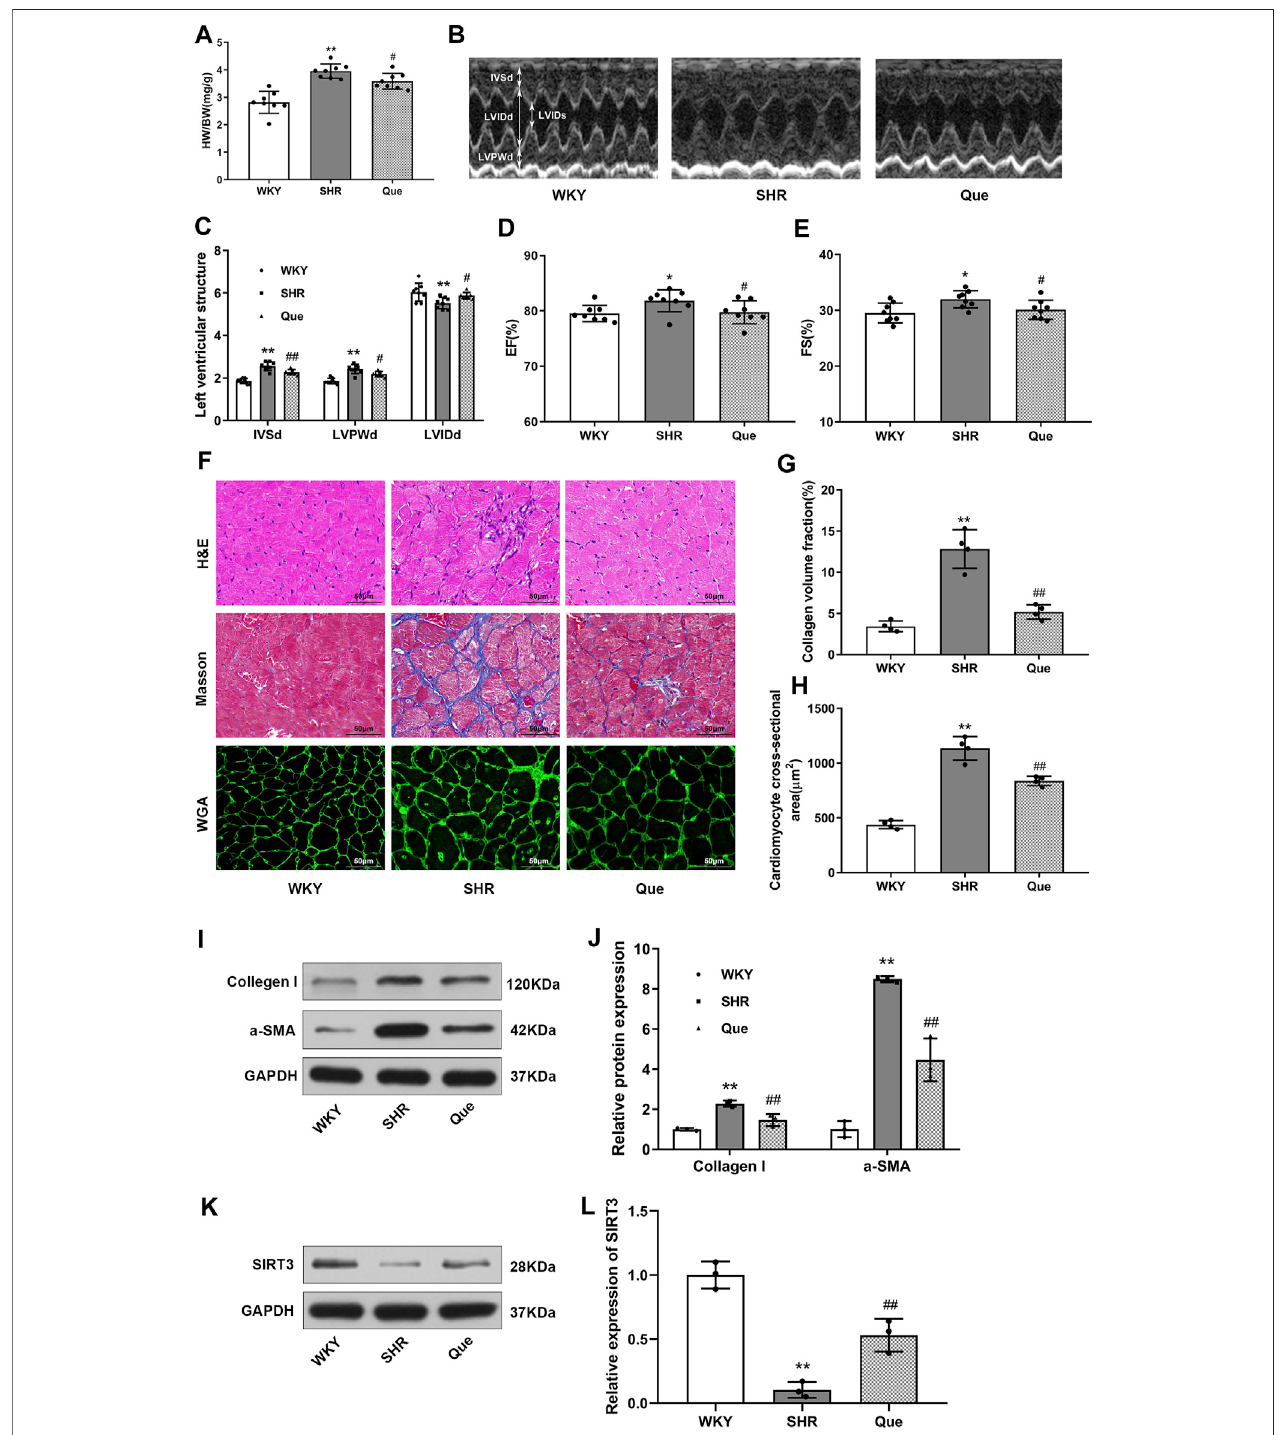
FIGURE 2 | Quercetin attenuates cardiac hypertrophy in SHRs. (A) Heart weight to body weight ratios (HW/BW, n (cid:1) 8). (B) Representative M-mode echocardiograms in WKY rats and SHRs. (C – E) Quantitative analysis of end-diastolic interventricular septal thickness (IVSd), left ventricular end-diastolic posterior wall thickness(LVPWd),leftventricularend-diastolicinternaldiameter(LVIDd),leftventricularejectionfraction(LVEF)andleftventricularfractionalshortening(LVFS)(n (cid:1) 8). (F) Representative histological images of the myocardium. In detail, hematoxylin and eosin (H&E) staining, Masson ’ s trichrome staining, and wheat germ agglutinin (WGA) staining in hearts from WKY rats and SHRs. Scale bar (cid:1) 50 μ m. ( G) Quantitative analysis of collagen volume fraction (n (cid:1) 4). (H) Quantitative analysis of cardiomyocyte cross-sectional area (n (cid:1) 4). (I,J) Representative blots of collagen I and α -smooth muscle actin ( α -SMA), and densitometric quanti fi cation after normalization to GAPDH levels (n (cid:1) 3). Data are mean ± SD. * p < 0.05, ** p < 0.01 vs WKY group; # p < 0.05, ## p < 0.01 vs SHR group.